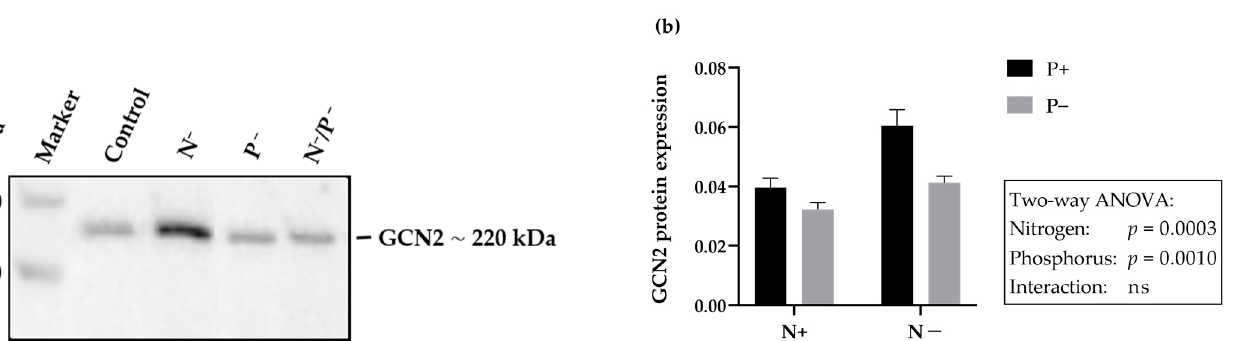
Figure 4. ( a ) GCN2 protein expression in the liver of young goats fed an N- and/or P-reduced diet, determined by Western blotting. Expression of GCN2 was quantified by densitometry and normalized to the total amount of protein. Western blotting results showed a representative blot. ( b ) Results were analyzed using two-way ANOVA analysis ( p < 0.05), followed by post hoc Tukey test for multiple comparison.